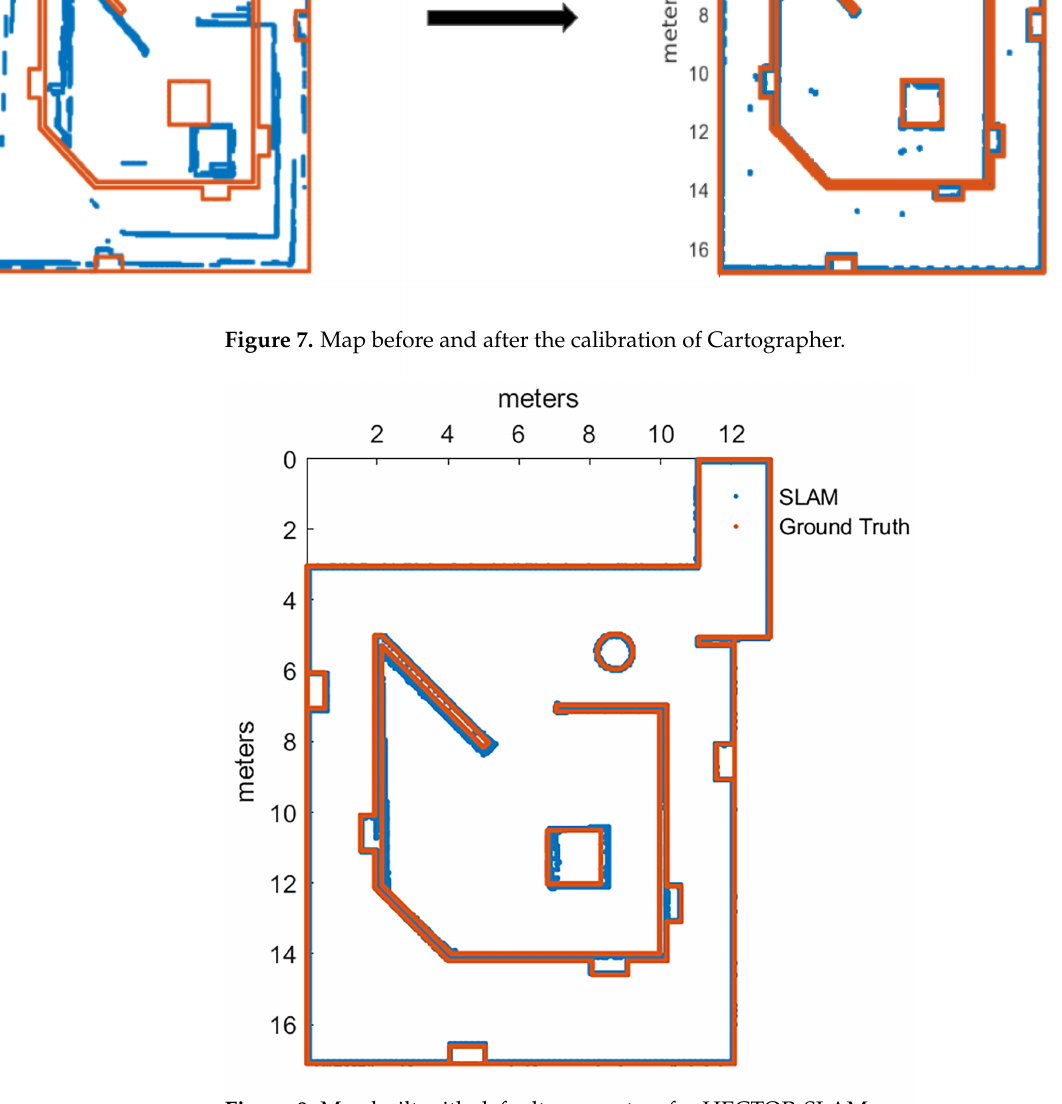
Figure 8. Map built with default parameters for